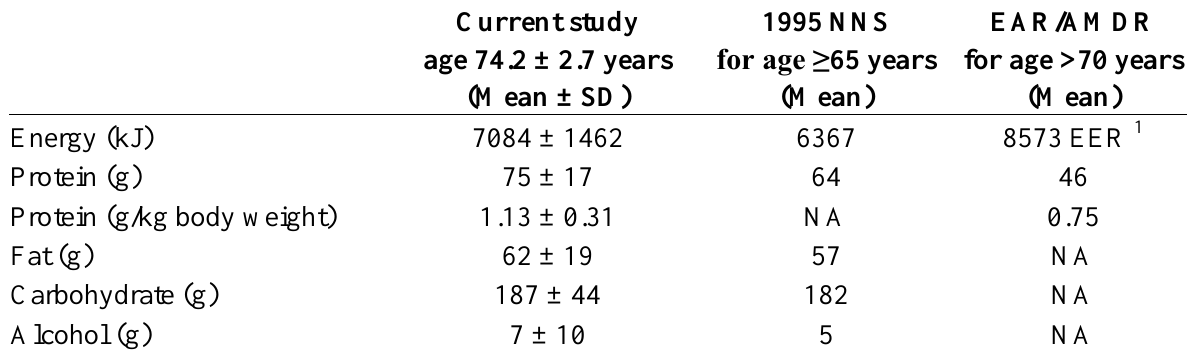
Table 2. Mean dietary intakes in the current study (n = 218) compared to the 1995 National Nutritional Survey (NNS) and Australian